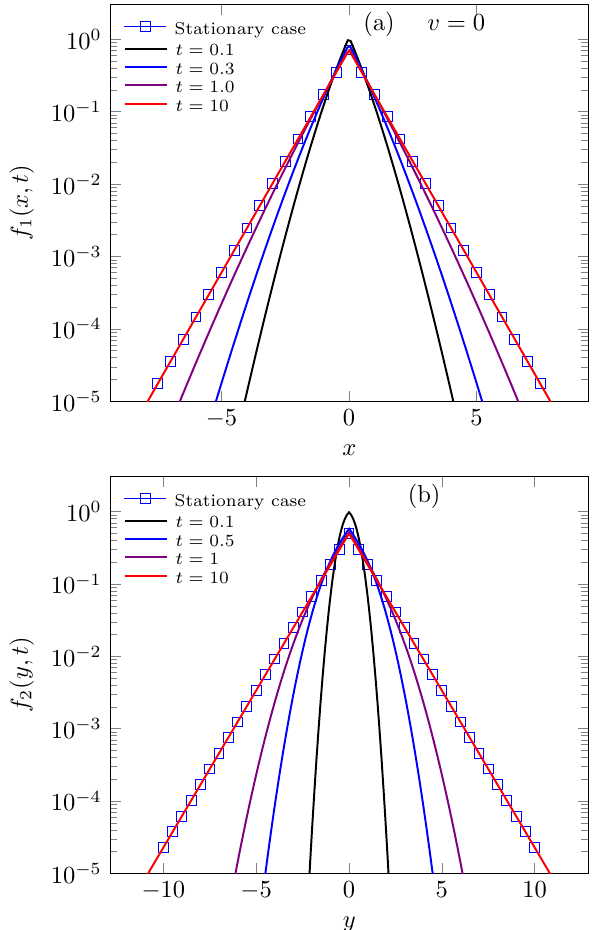
Figure 2. These figures represents time evolution behavior to marginal distributions to static stochastic resetting v = 0. Figure ( a ) represents the solution (17) and Figure ( b ) represents the solution (19) to different time valuer. Both figures consider the parameter valuers as follow